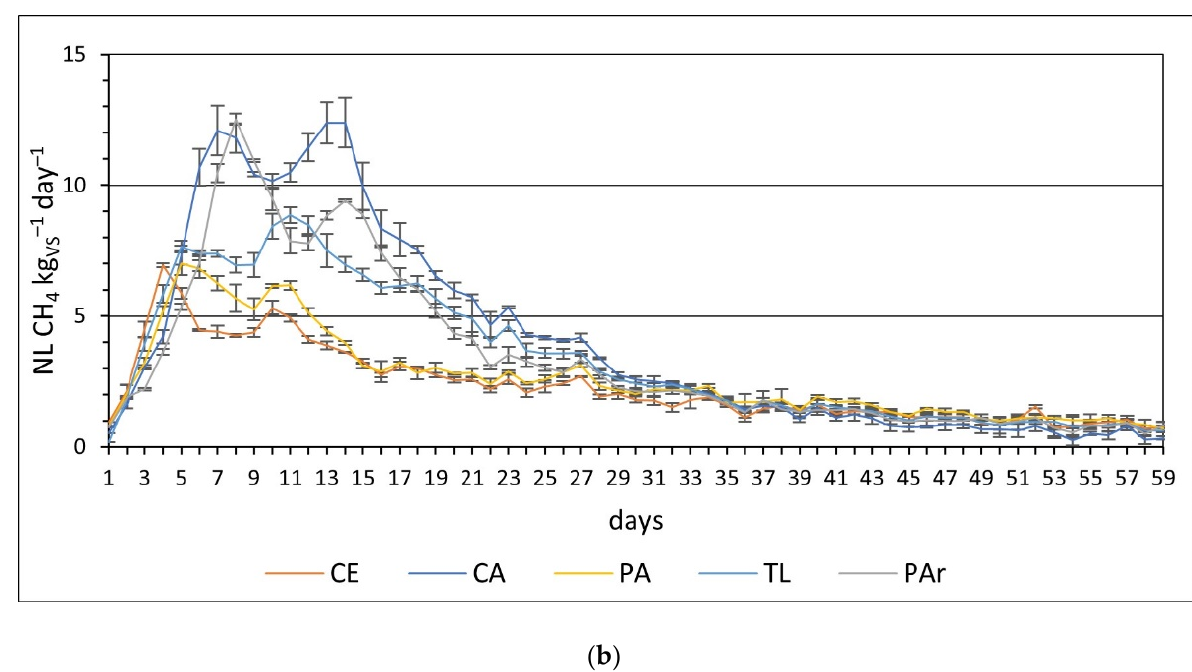
Figure 3. Daily methane production: ( a )—wet fermentation; ( b )—dry fermentation. CE— Carex elata ; CA— Carex acutiformis + Carex elata ; PA— Phragmites australis ; TL— Typha latifolia ; PAr— Phalaris arun- dinacea . Standard errors are shown as vertical bars.